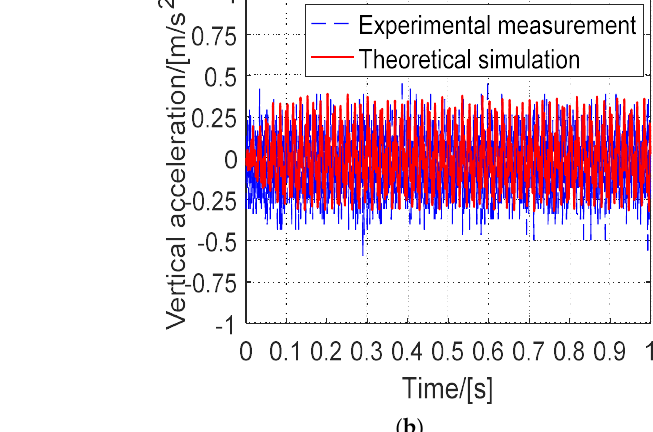
Figure 10. Comparison of simulation and measurement results: ( a ) horizontal acceleration; ( b ) vertical acceleration.